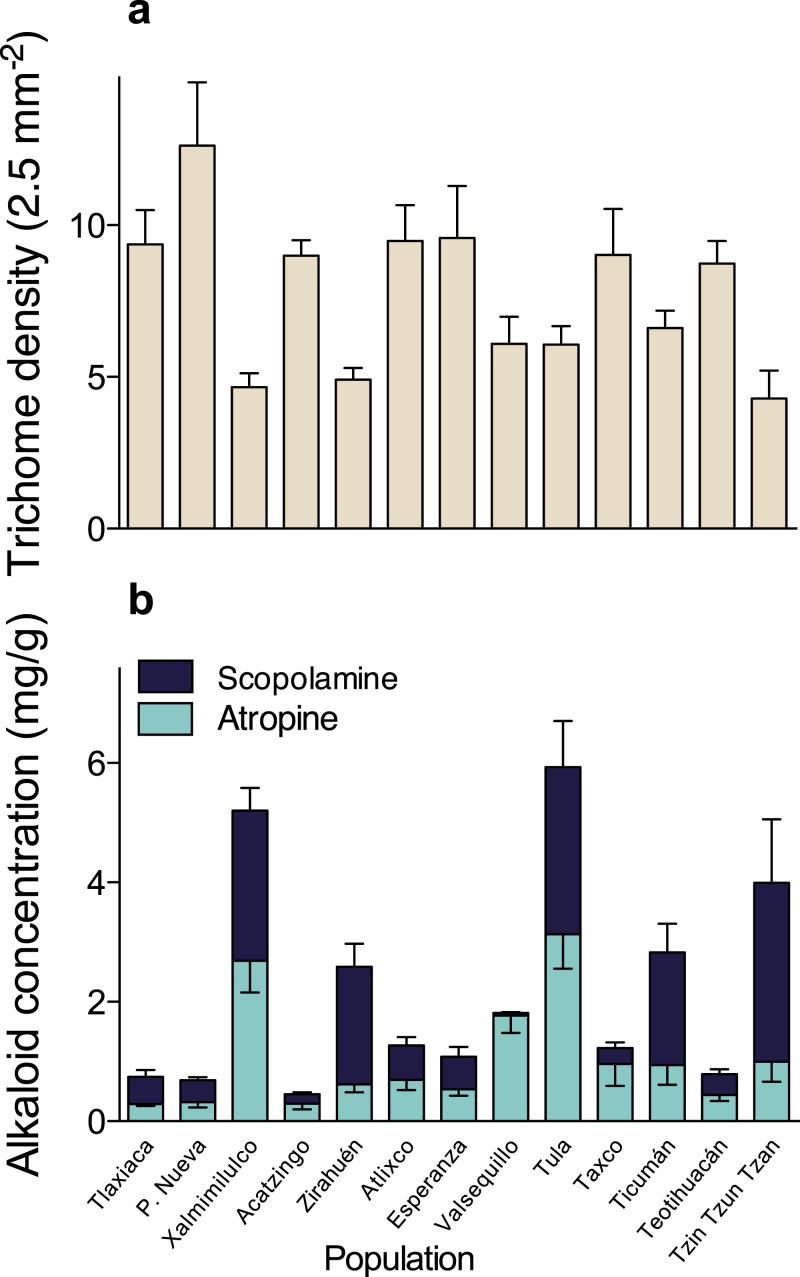
Among-populations variation in leaf trichome density (A), and atropine and scopolamine concentration (B) in 13 populations of Datura stramonium in central Mexico.Bars represent average value +1 SE.